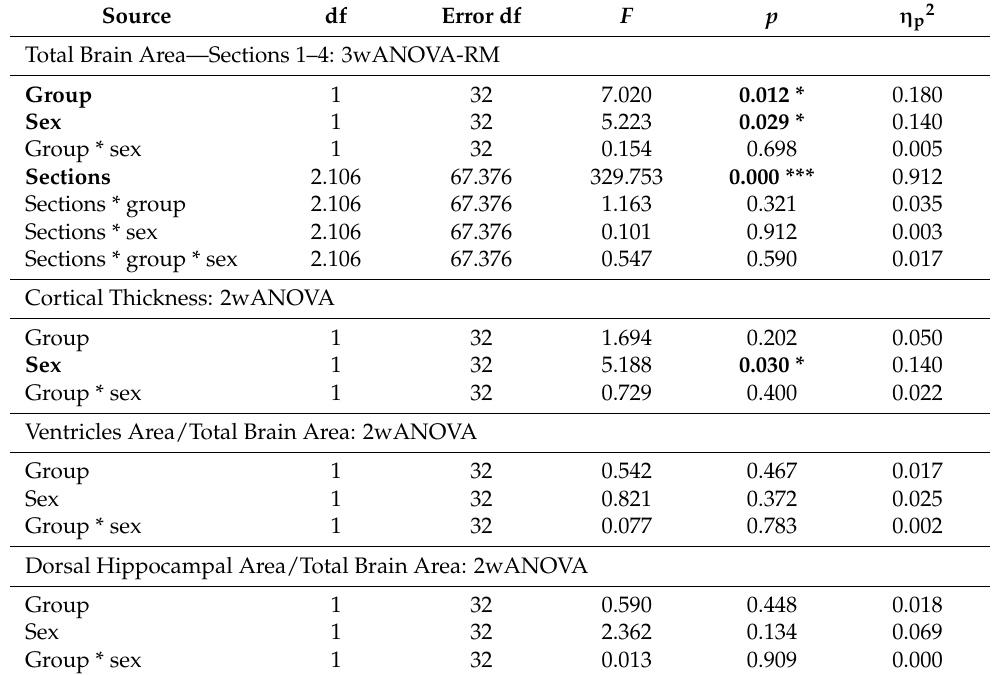
Table A2. Three-way ANOVA-RM and two-way ANOVA table for brain morphology parameters.